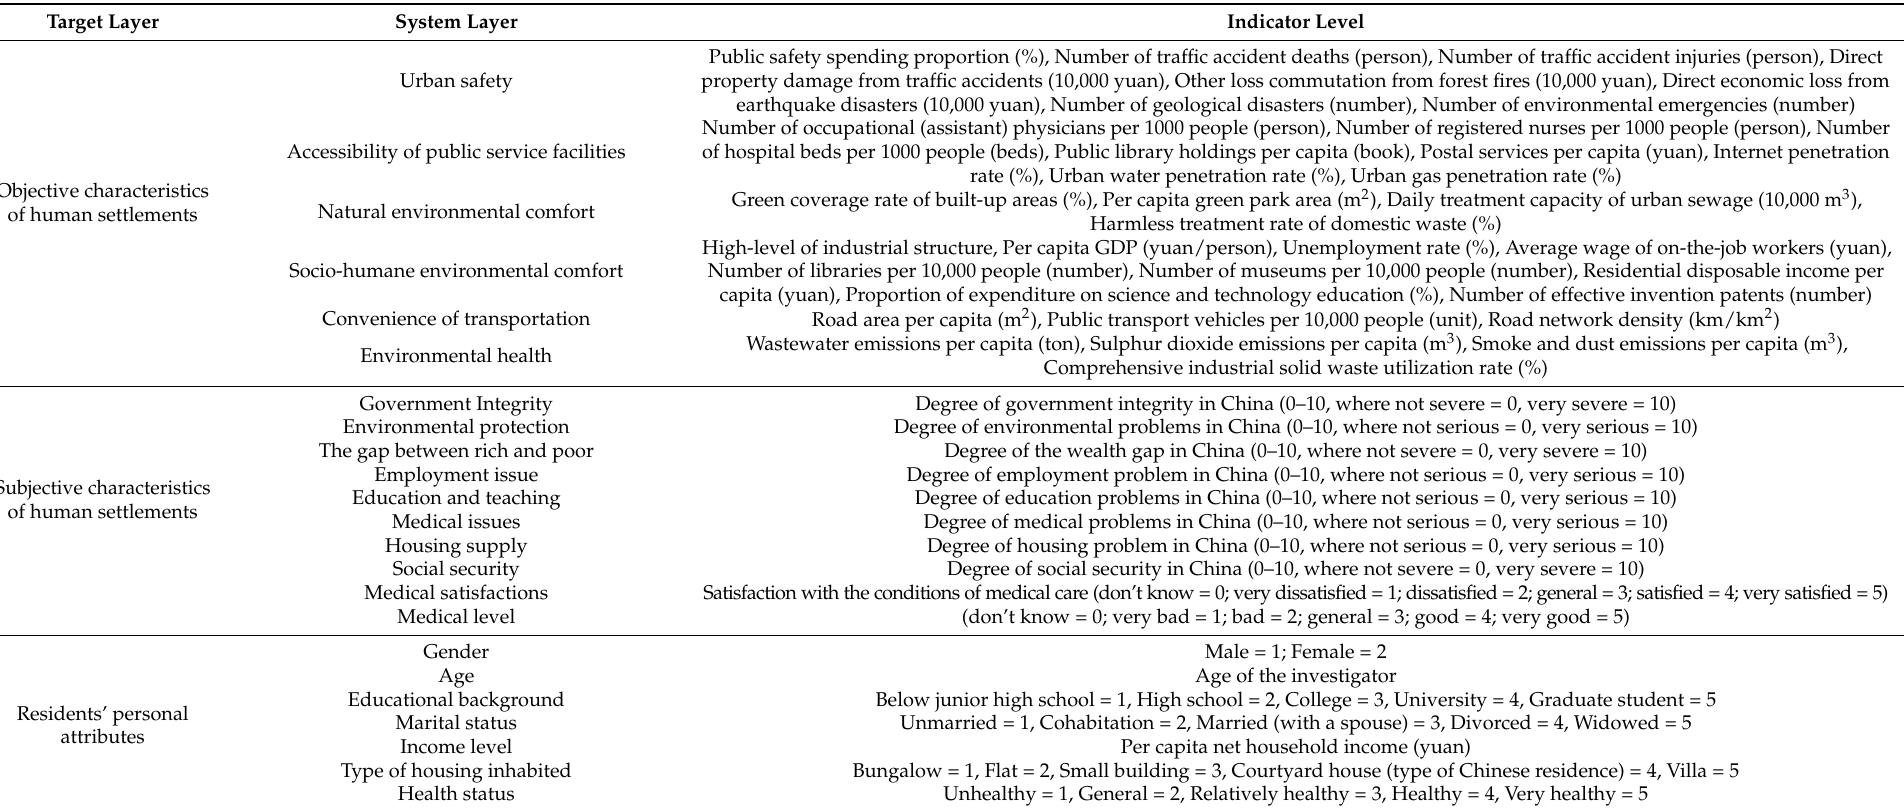
Table 1. Description of related